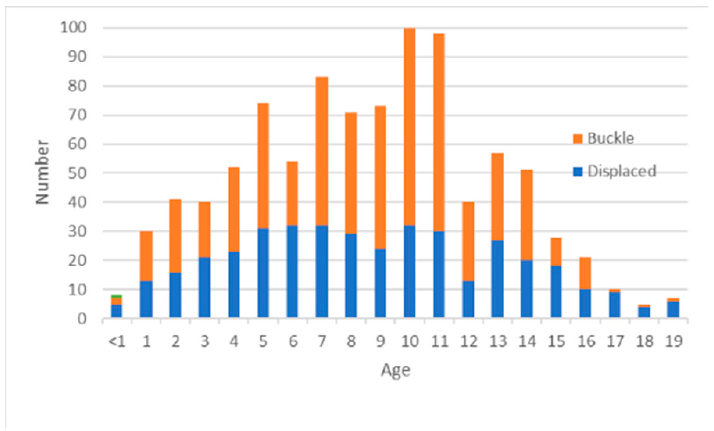
Figure 2. Distribution of patient age and fracture type in displaced (blue) and buckle (orange) fractures.